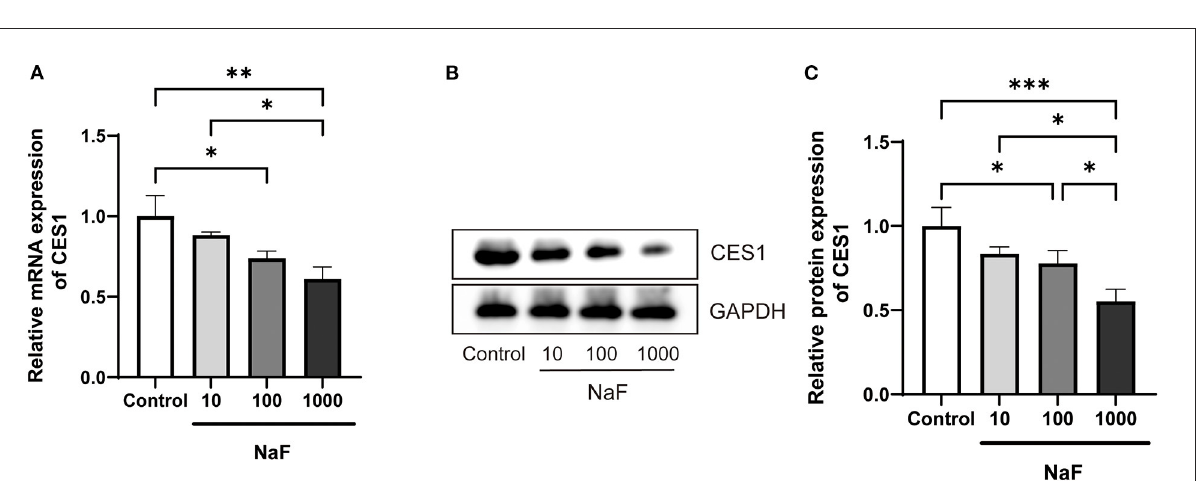
FIGURE3 Down-regulated mRNA and protein expression levels of CES1 treated with different concentrations of sodium fluoride in HepG2 cells. (A) mRNA expression level of CES1 ; (B) The representative immunoblot band of CES1; (C) The normalization of CES1 to the internal reference protein GAPDH as control. HepG2 cells were treated with sodium fluoride (10, 100 and 1000 µ M) or the same volume of PBS for 24h. Total RNA was isolated and cell lysates were prepared for qRT-PCR and western blot analysis. Data are presented as mean ± SD ( n = 6 each). * P < 0.05, ** P < 0.01, *** P < 0.001. NaF, sodium